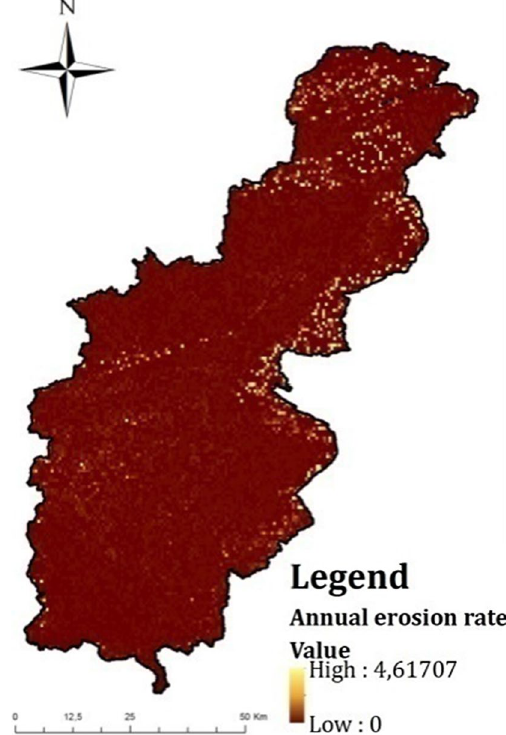
Fig. 7 Average annual soil erosion